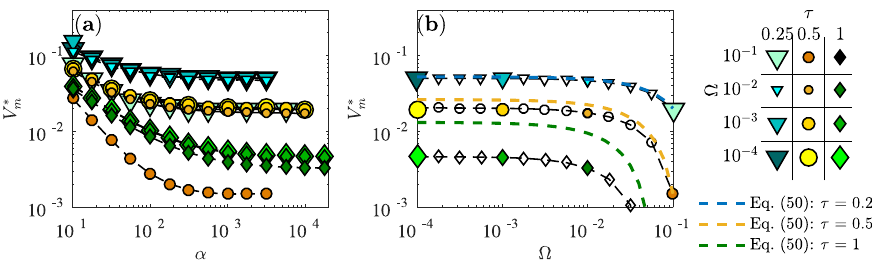
Figure 8. Panel (a) : asymptotic behavior for τ ∼ 1 where we expect a limiting behavior of V ∗ m = V m α − 2 = g ∗ ((cid:127),τ) for α (cid:29) 1; see Eq. (49). The limiting behavior is confirmed by convergence to constant values for α (cid:29) 1. Panel (b) : asymptotic behavior of V ∗ m against (cid:127) = Pe α − 2 along constant values of τ at values of α where convergence is observed. Dashed lines show the analytical solution (Eq. 50), which is valid for τ (cid:28) 1.